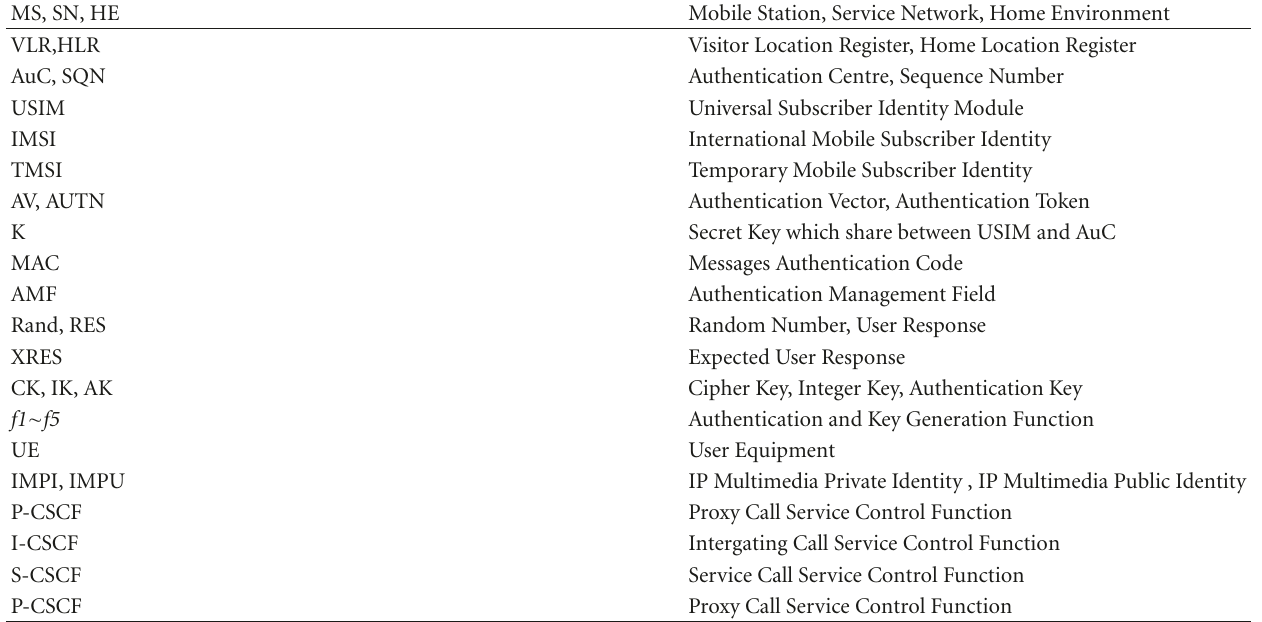
Table 1: Symbols used in